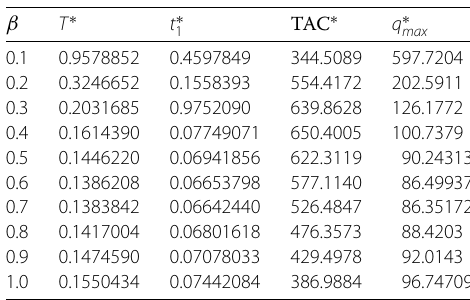
Table 6 Result for Case